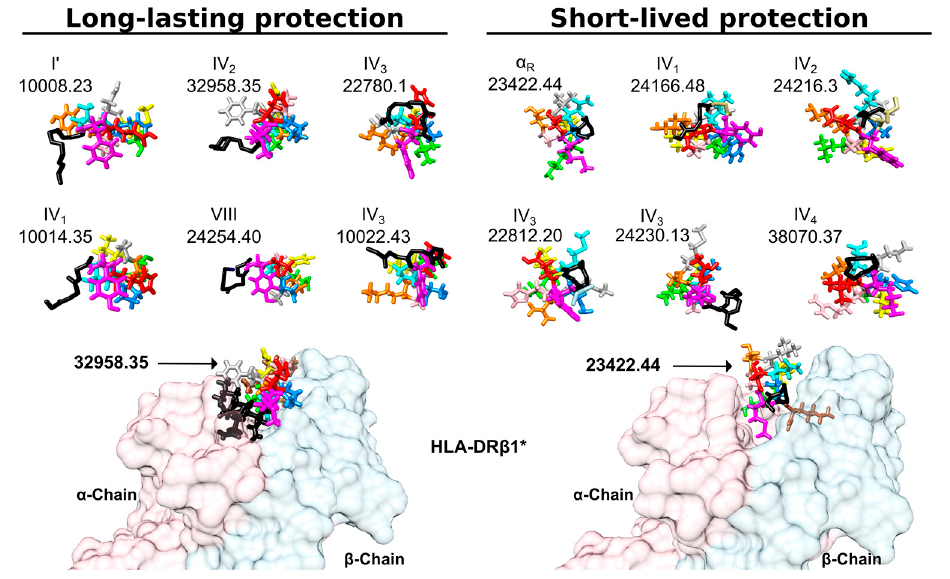
Figure 6. PFR beta structure: the front view shows long-lasting protective and short-live protection inducers. The colour code is the same as that used in Figure 3. Black sticks highlight the backbone of N-terminal peripheral region residues forming β -turn or α -helixes. Note that most structures were left-hand orientated suggesting an interaction with the HLA-DR α -chain to collaborate in stabilising this complex. Also note the total absence of the most frequent β -turn types, such as I, II and II’.